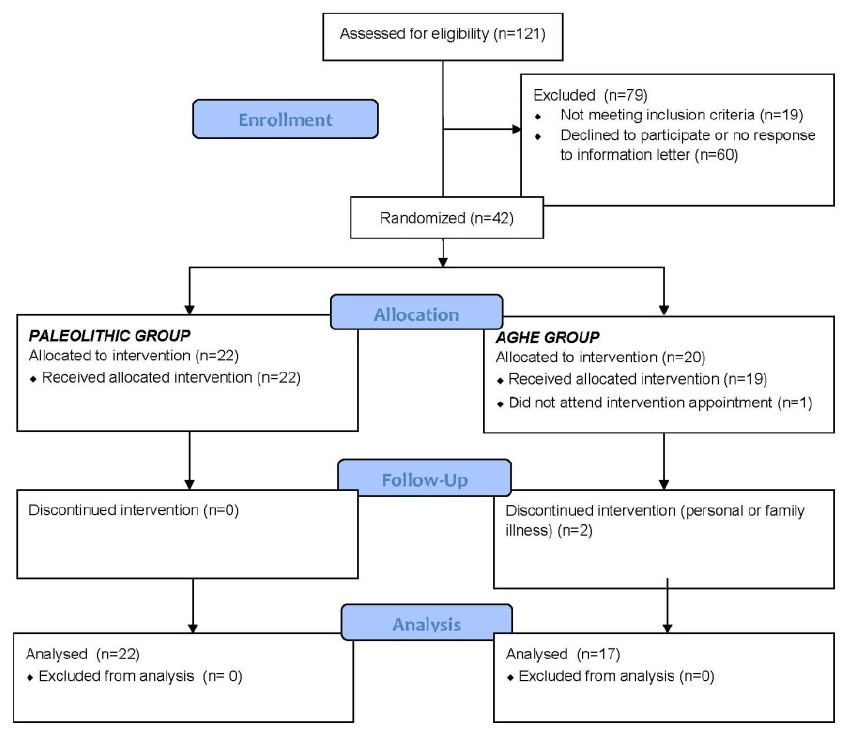
Figure 1. Flow diagram of subjects’ participation in the trial.